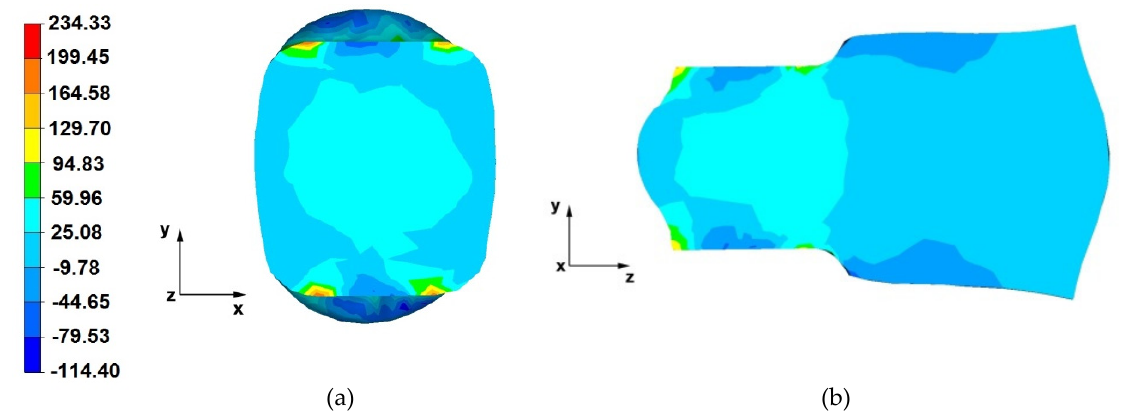
Figure 9. Distribution of the hydrostatic pressure of the AZ 91 alloy forging, deformed in the fourth pass with 40% reduction in flat anvils after slanting by 90°: ( a ) on the cross-section, ( b ) on the longitudinal section.